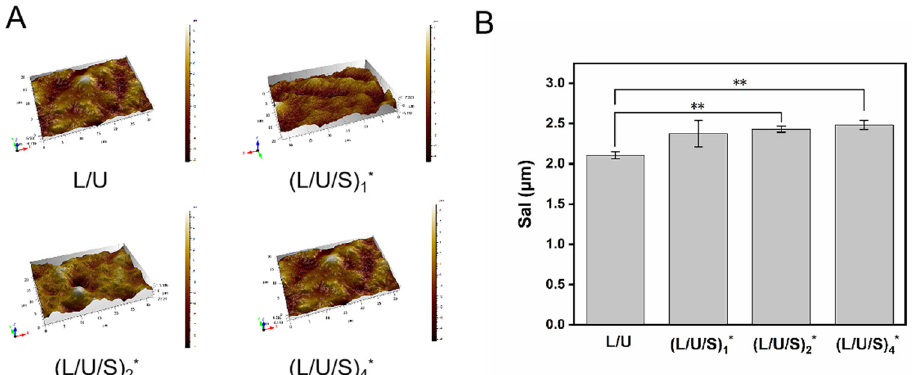
Figure 3. ( A ) Three-dimensional surface height pattern diagram of electrospun fibers, ( B ) analysis of smoothness parameters of electrospun fibers. (L/U/S) 1* , (L/U/S) 2* , (L/U/S) 4* referred to the sample of smoothness parameters of electrospun fibers. (L/U/S) 1 * , (L/U/S) 2 * , (L/U/S) 4 * referred to the after (L/U/S) 1 , (L/U/S) 2 , (L/U/S) 4 were cross-linked, respectively. * p < 0.05, ** p < 0.01. sample after (L/U/S) 1 , (L/U/S) 2 , (L/U/S) 4 were cross-linked, respectively. ** p <